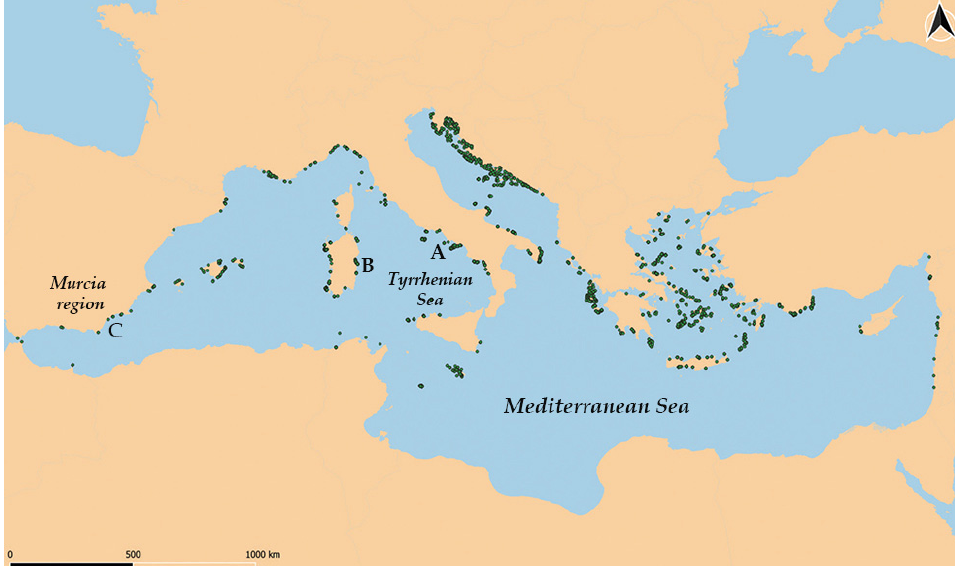
Figure 1. Distribution of known marine caves (green dots) in the Mediterranean Sea. ( A ) Isca cave (Tyrrhenian coast); ( B ) Bue Marino and Bel Torrente caves (Gulf of Orosei); ( C ) CT12 (Murcia region) [modified from 60].